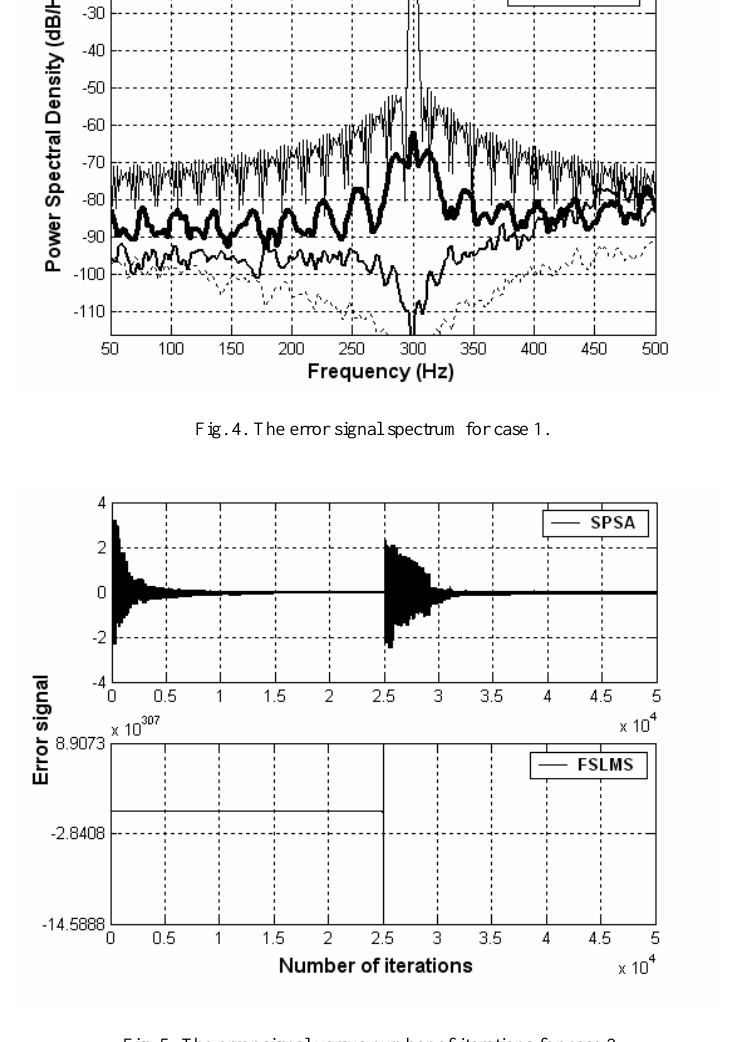
Fig. 5. The error signal versus number of iterations for case